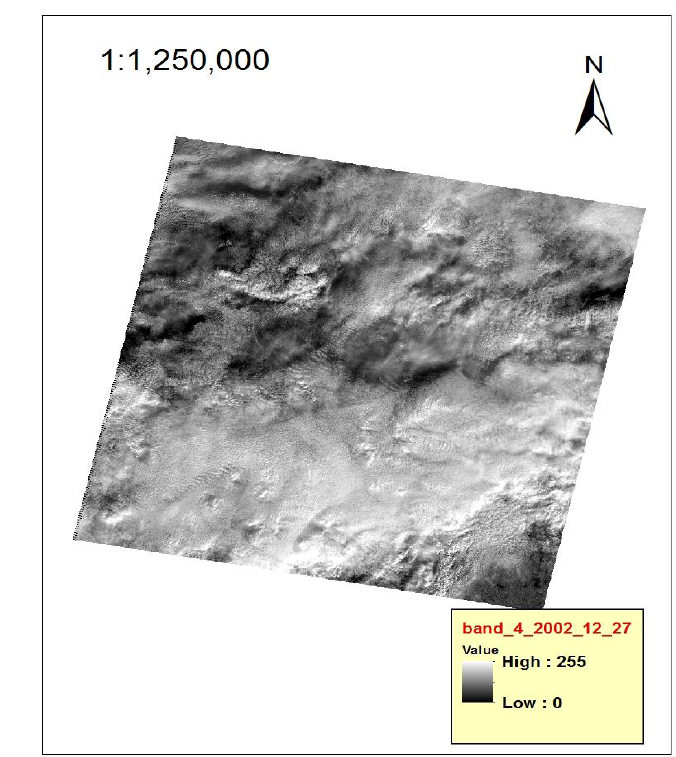
Fig.1: Show image of band (4) for study area in date (27/12/2002).